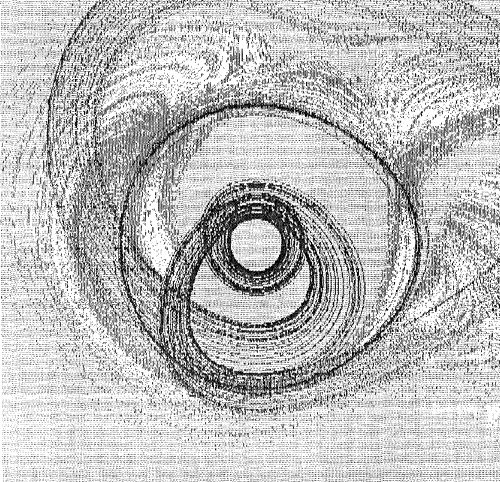
FIGURE 9 Projections of the co-existing attractors in sys- tem (6) for m 1.42, g-0.097 and the structure of the basins of their attraction in the Poincare section z 1.